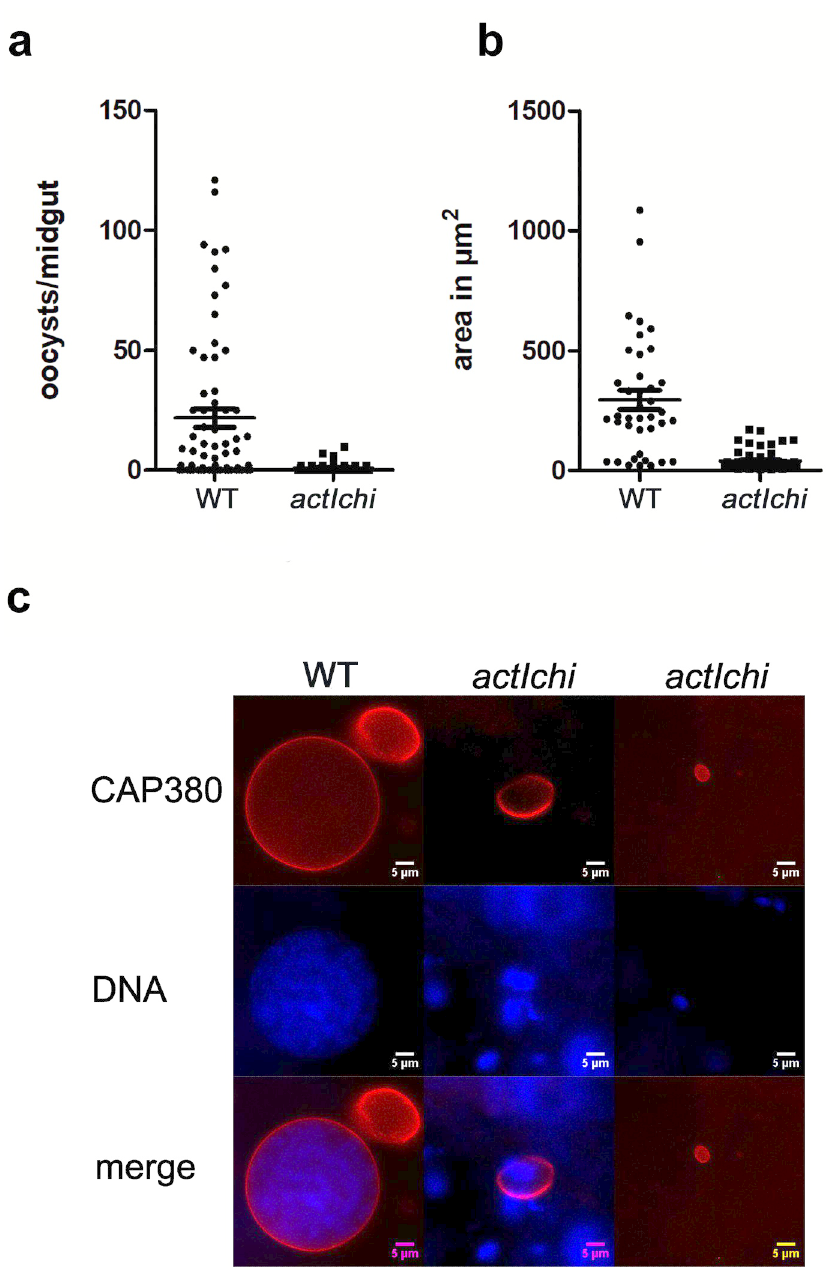
Fig 5. Oocyst development is blocked in the actIchi mutant. Oocysts at day 12 in mosquitoes fed on WT and actIchi infected mice. (a) Number of Cap380 labeled oocysts per midgut (WT n = 39, actIchi n = 61). Difference is significant, Mann-Whitney test, P < 0.0001. (b) Area in μ m 2 of WT and actIchi oocysts. The area of 39 WT and 61 mutant oocysts from the experiment in (a) were measured in ImageJ. Differences are statistically significant p < 0.0001 Student’s t-test. (c) Examples of WT and two representative types of mutant oocysts labeled with the Cap380 antibody (red) and stained for DNA with Hoechst 33342 (blue). Scale bars 5 μ m. Raw data related to panels a and b can be found in S1